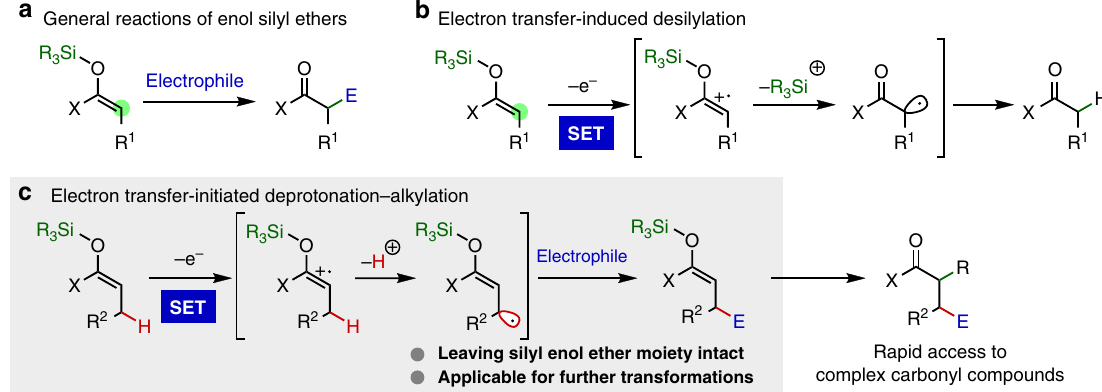
Fig. 1 Transformations of enol silyl ethers. a General reaction pathway. b Known desilylation reaction initiated by single-electron oxidation. c The reaction design of allylic C – H